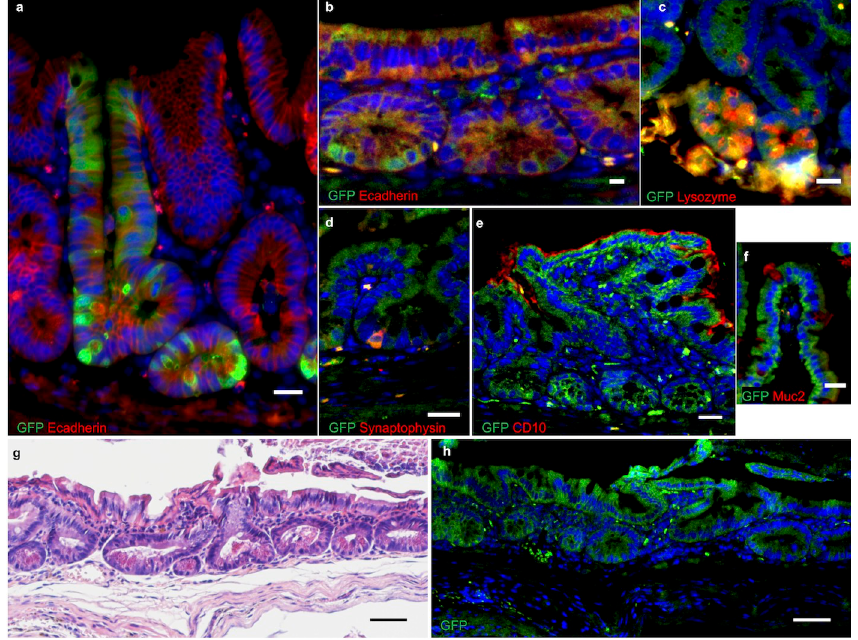
Fig 3. Immunofluorescence stains of engrafted GFP murine spheroids in wild type mouse small intestine. (a) one week after implantation; (b-f) four weeks after implantation: (b) E-cadherin, (c) lysozyme, (d) synaptophysin, (e) CD10, (f) Muc2. (g-h) H&E stain and GFP immunofluorescence of consecutive slides of engrafted mouse intestine four weeks post-implantation. Nuclei are counter-stained with 4’,6-diamidino-2-phenylindole (DAPI). Scale bars, 20 μ m (a-f) and 50 μ m